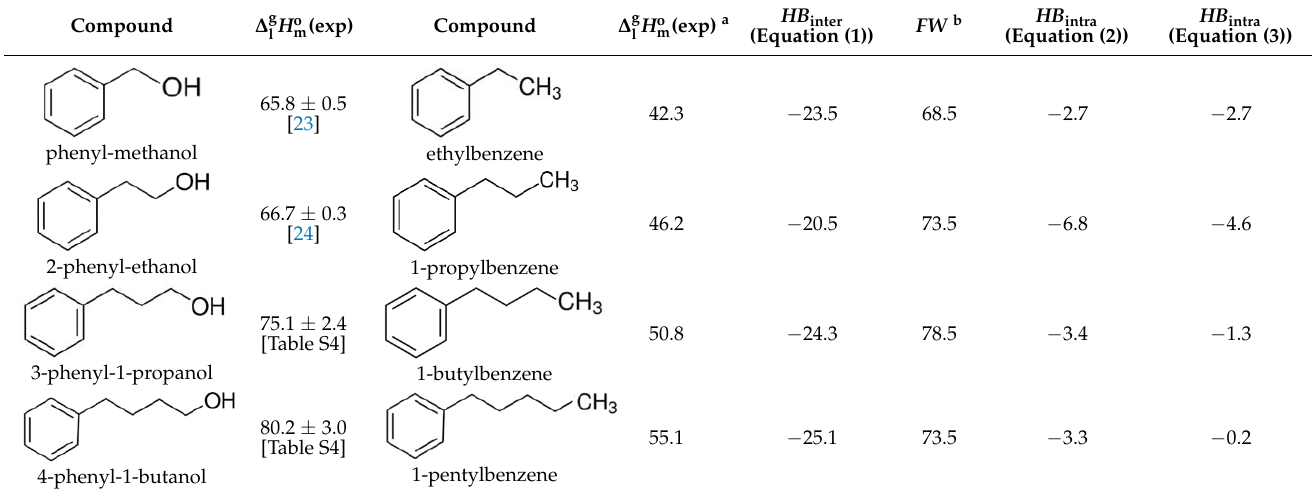
Table 3. Experimental enthalpies of vaporisation of hydroxy-alkyl-benzene and alkyl-benzenes and the strength of inter- and intra-HB calculated from these values (at 298 K, in kJ mol −1 ).